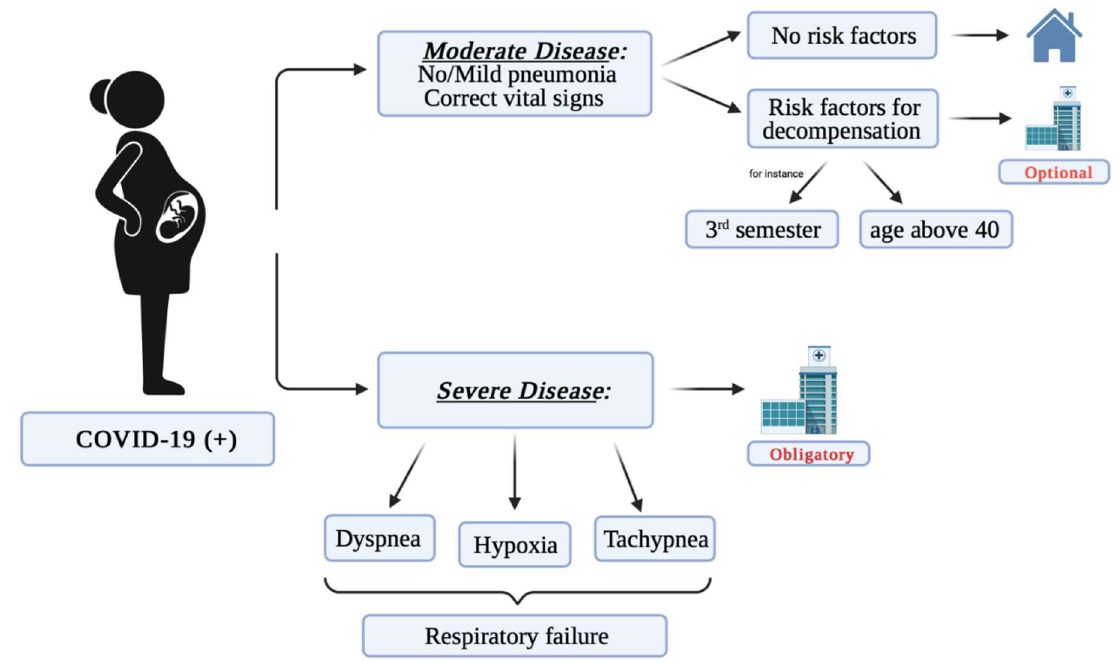
Figure 1. The potential course of COVID-19 depending on the severity of disease symptoms.